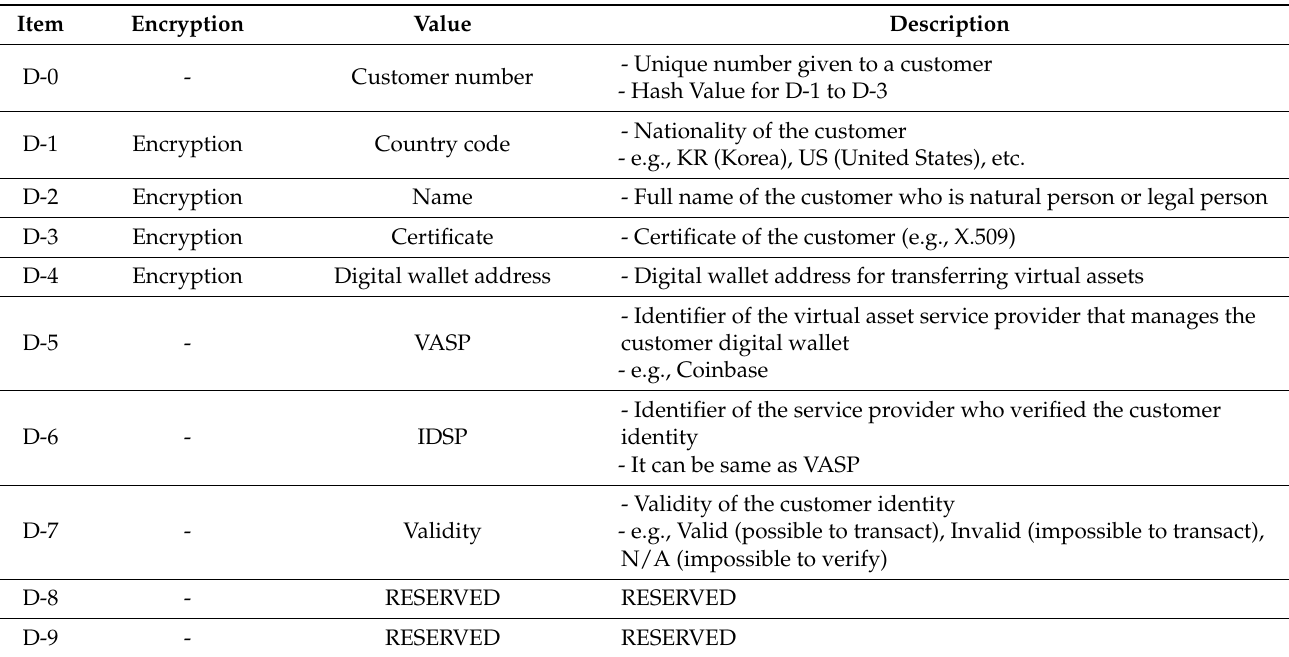
Table 1. Basic data format.